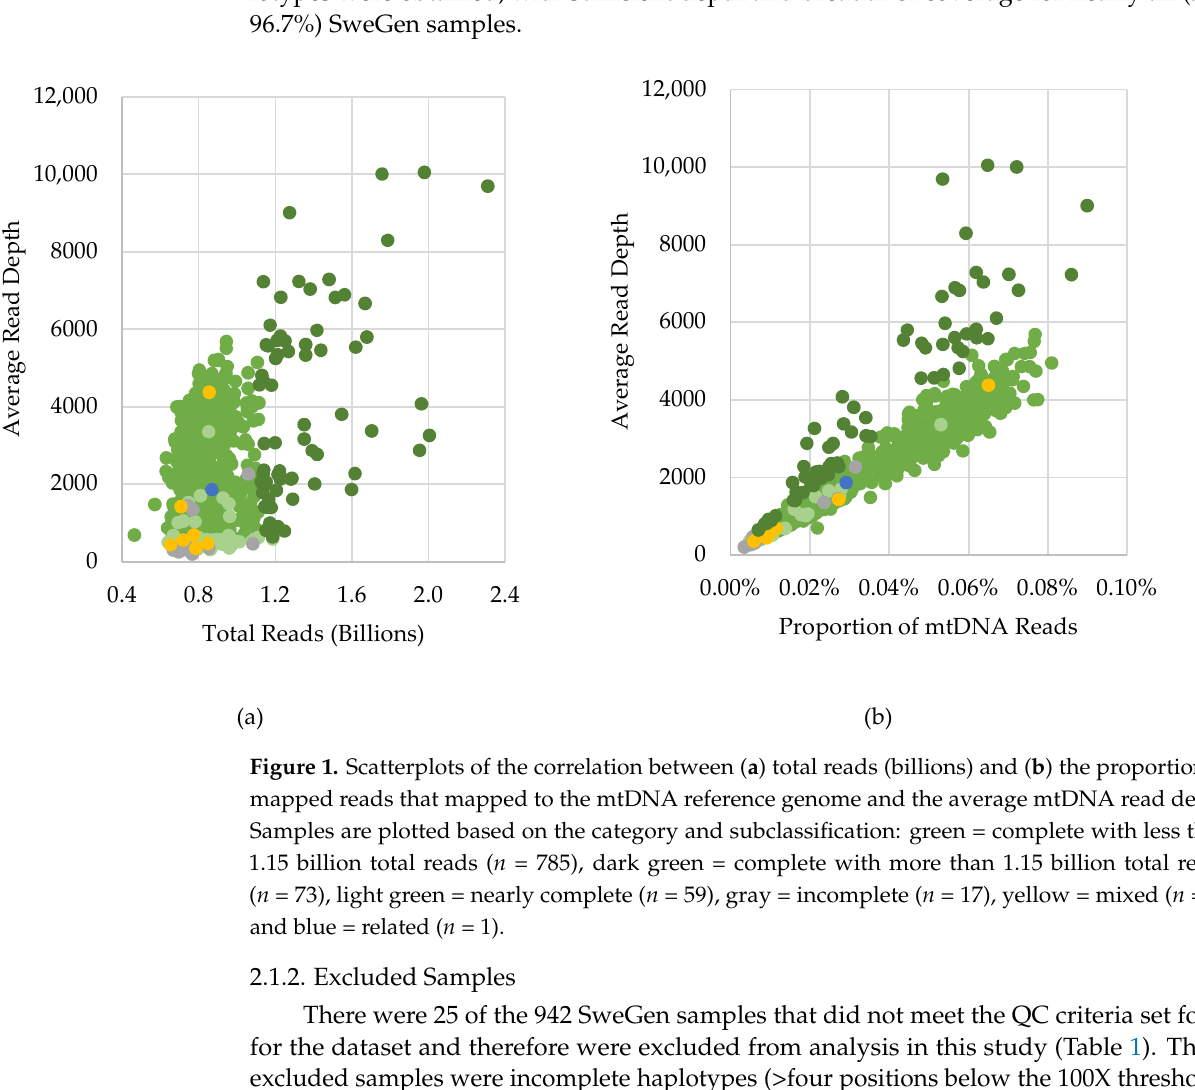
Table 1. Average analysis metrics for each sample category based on the mitochondrial DNA (mtDNA) analysis of the SweGen dataset. The passing category includes complete (all positions with at least 100X read depth) and nearly complete (one to four positions below 100X) haplotypes that met all quality control criteria. Incomplete haplotypes (five or more positions below 100X), pos- sible mixtures and related samples were excluded from the analysis. The “% Mapped Reads” is the proportion of total reads that mapped to the GRCh37 and the “% mtDNA Reads” is the proportion of the mapped reads that aligned to the mtDNA reference genome.